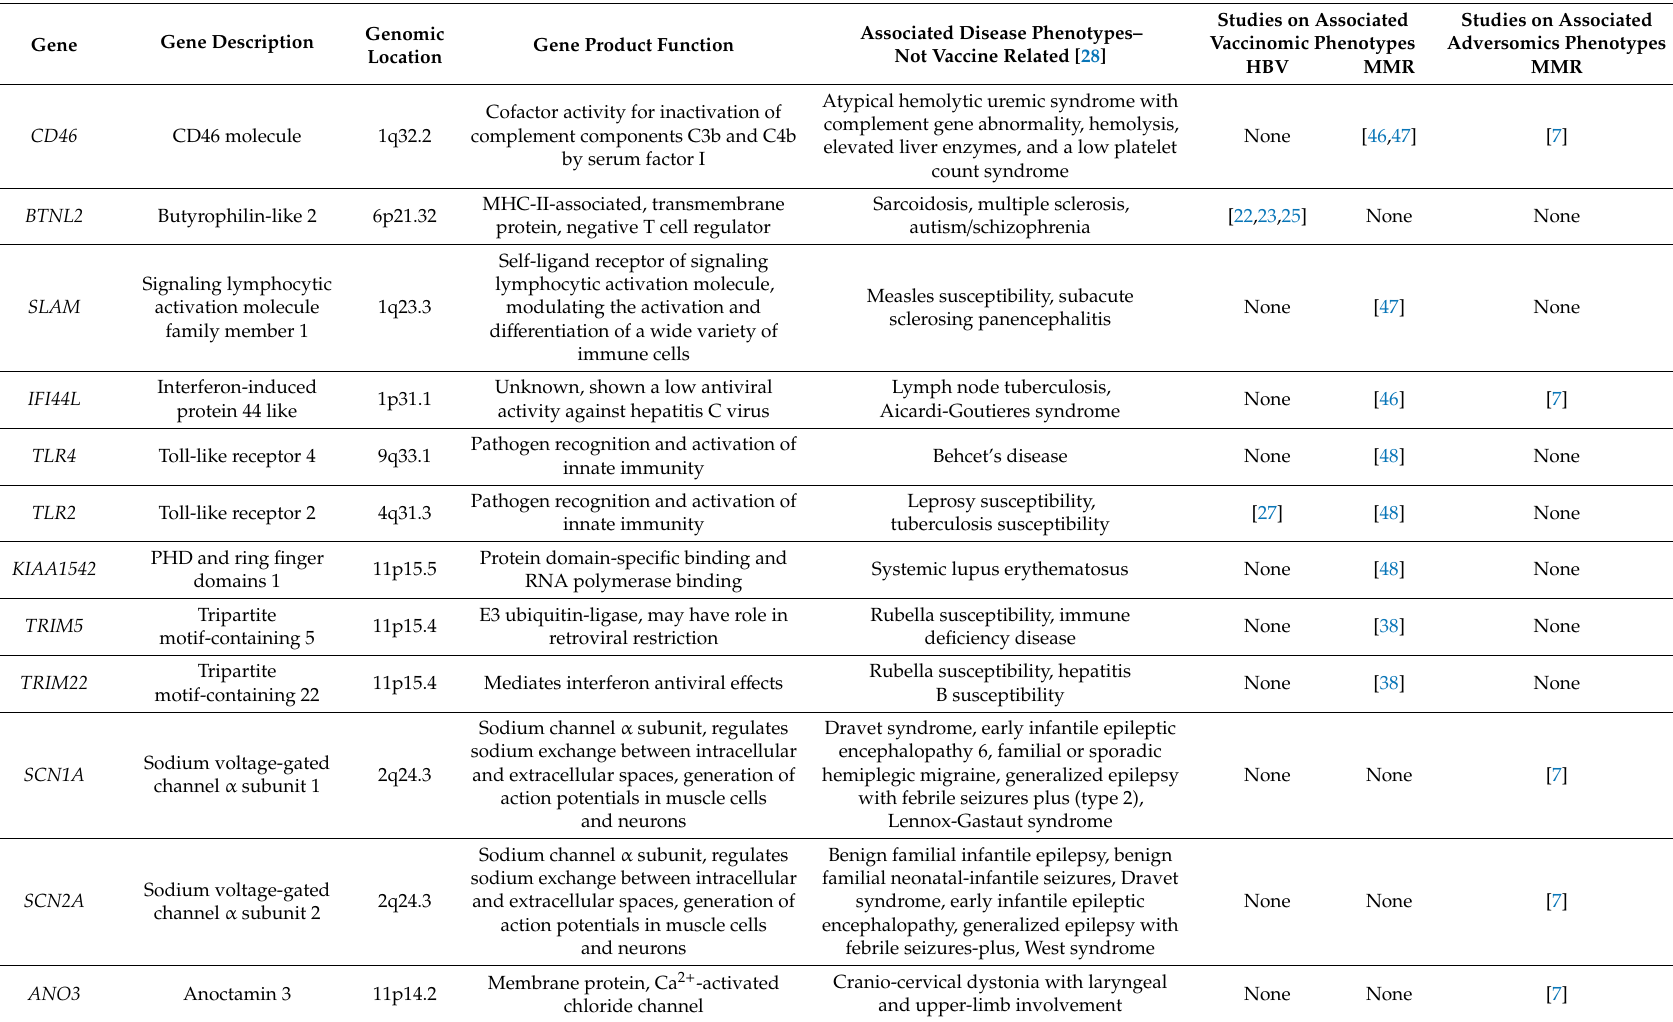
Table 4. Details of other genes associated with HBV and MMR vaccine e ffi cacies and